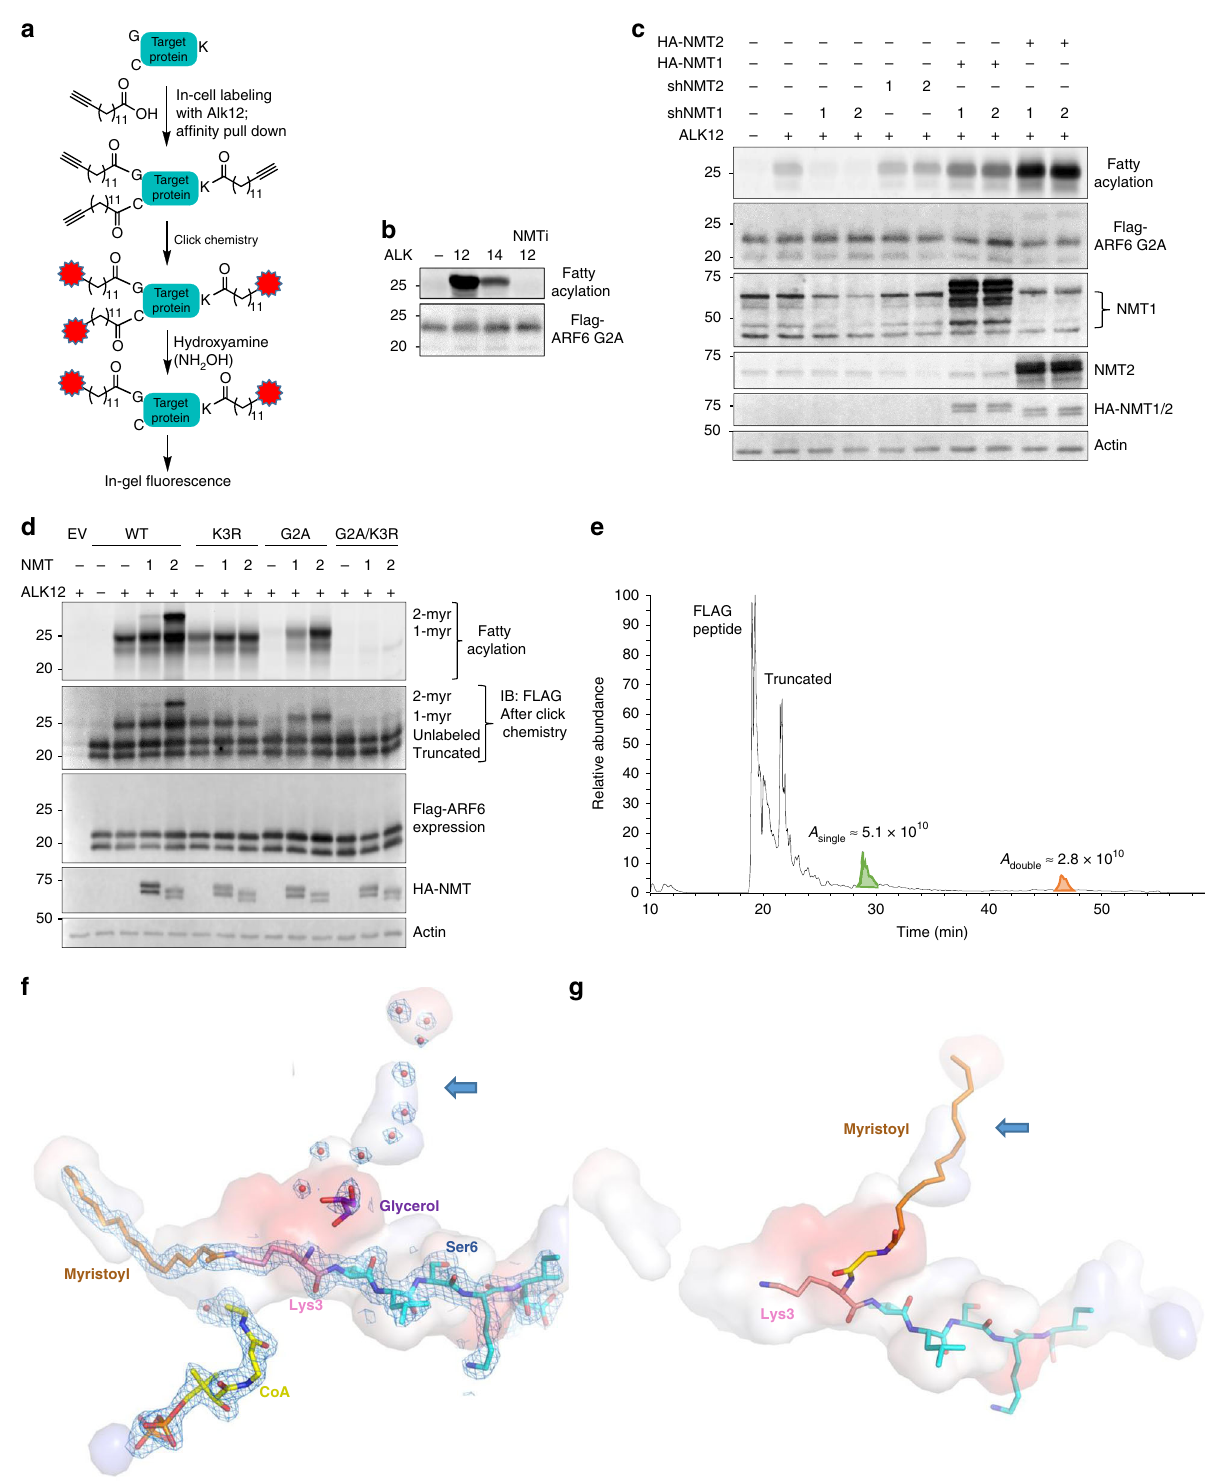
Fig. 2 Biochemical and structural evidence for the NMT activity on lysine. a In-cell Alkyne probe labeling scheme. b Alk12 labeling is more ef fi cient than Alk14 labeling and NMT inhibition abolishes labeling. c NMT1 but not NMT2 knockdown inhibits lysine myristoylation in HEK293T cells. d NMT1 and NMT2 overexpression produce singly and doubly myristoylated ARF6 based on Alk12 labeling. e Total ion chromatogram from a top – down mass spectrometric analysis that reveals di-myristoylated ARF6 isolated from HEK293T cells with NMT2 overexpression. Con fi rmatory MS/MS data are found in Supplementary Fig. 4. f Interior pockets (shown as surface) around the NMT2 active site, showing possible channel for second myristoyl (blue arrow) currently occupied by waters (red dots) and glycerol (purple). The surface is colored by the electrostatic properties of the surrounding residues: blue (positive), red (negative), and gray (hydrophobic). The 1.3 σ 2 F O – F C electron density map is shown as a mesh. g Model of myristoyl-glycine docked in the second pocket, with lysine ready for a second myristoylation